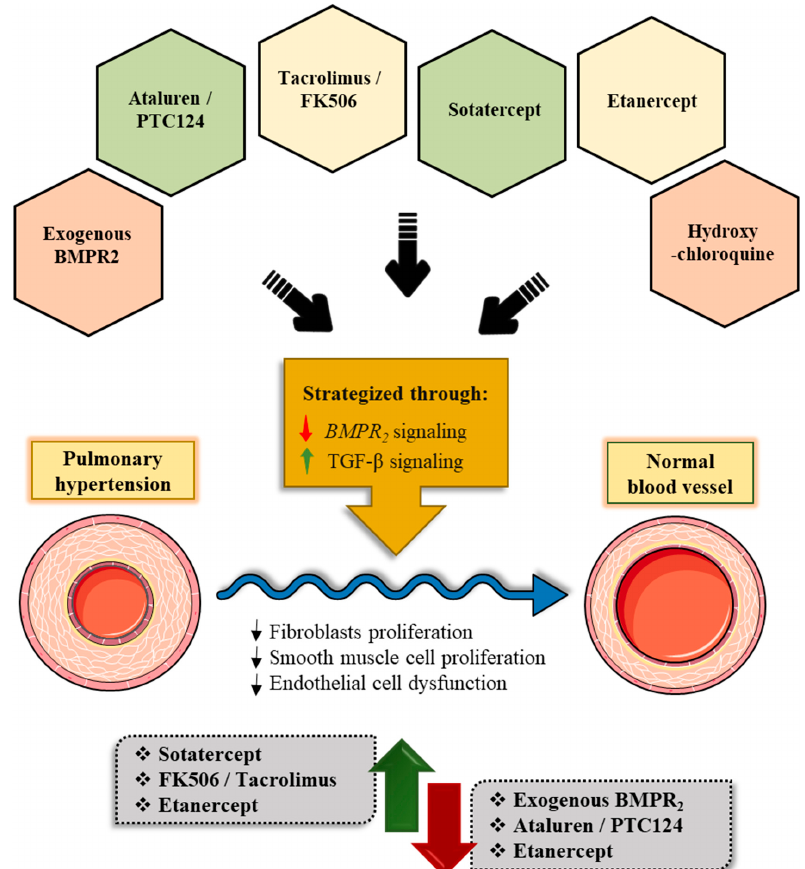
Figure 8. Emerging and existing therapeutic targets that ameliorate the expression of BMPR2 and/or BMP signaling. A better understanding of the molecular and genetic components in PAH has opened new avenues for the development and testing of novel therapeutic modalities. Increasing stability of the BMPR2/BMP and TGFb pathways will be essential for maintaining normal vascular homoeostasis. Manipulation of these pathways will be crucial for reducing/reversing the vascular remodeling that is linked to PAH pathogenesis.